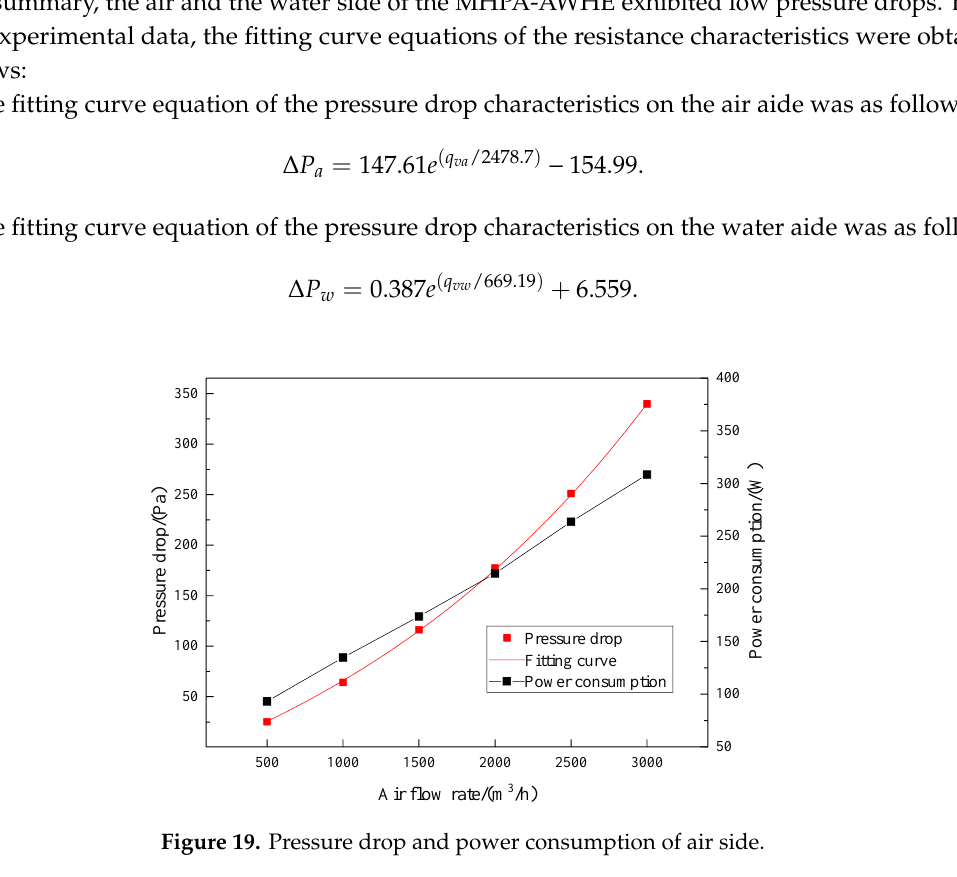
Figure 20. Pressure drop and power consumption of water side. 3.4. Comprehensive Performances of MHPA-AWHE Figure 21 showed the variation of the heat transfer factor j for different values of Re on the air side. The MHPA-AWHE with serrated fins and the plate – fin air – water heat exchanger with louvered fins selected by Wang [18 – 20] were compared. The heat transfer factor j decreased quickly when Re was less than 600, and the two kinds of heat exchangers exhibited similar trends. The heat transfer factor j decreased gently when Re was larger than 600. The average heat transfer factor j studied by Wang increased by 3.3% compared with the MHPA-AWHE. The reason was that the form of the louvered fins was more complicated than that of the serrated fins, and the disturbance of air flow was more significant. Although the heat transfer factor j of the heat exchanger with louvered fins was better, the friction factor f of the heat exchanger with louvered fins was significantly lower than that of the MHPA-AWHE with serrated fins. As Re increased from 200 to 1200, the average friction factor f of the MHPA-AWHE decreased by 34.7% compared to the heat exchanger with louvered fins. In this study, the exponential function of the friction factor f in the Re range from 200 to 1200 also fitted.